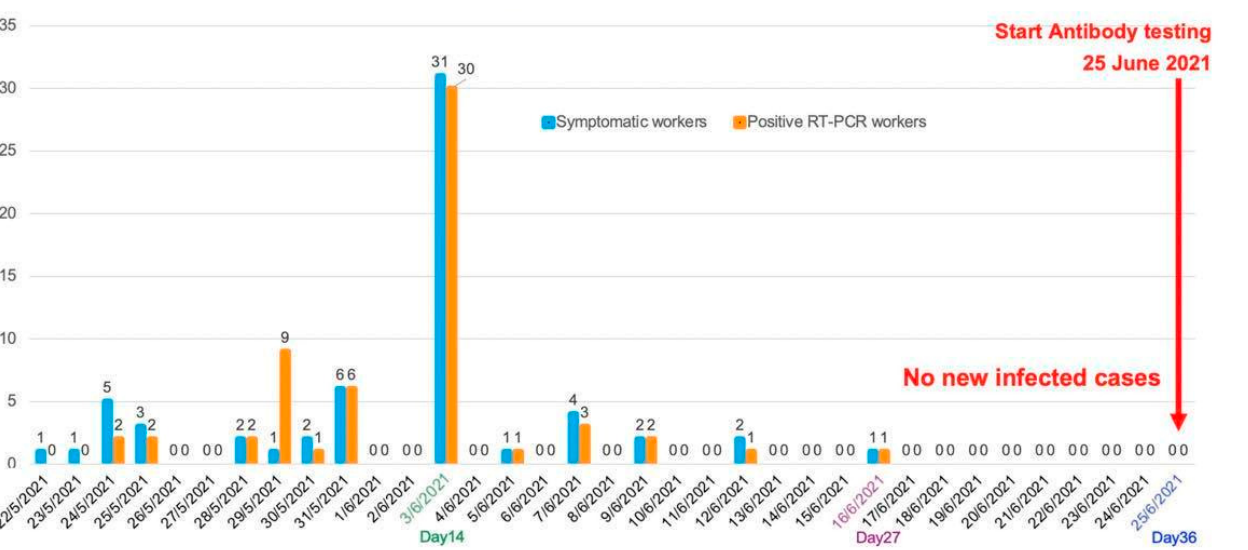
Figure 1. Date of diagnosis and number of RT-PCT-confirmed COVID-19 cases before start- ing the Bubble and Seal program.